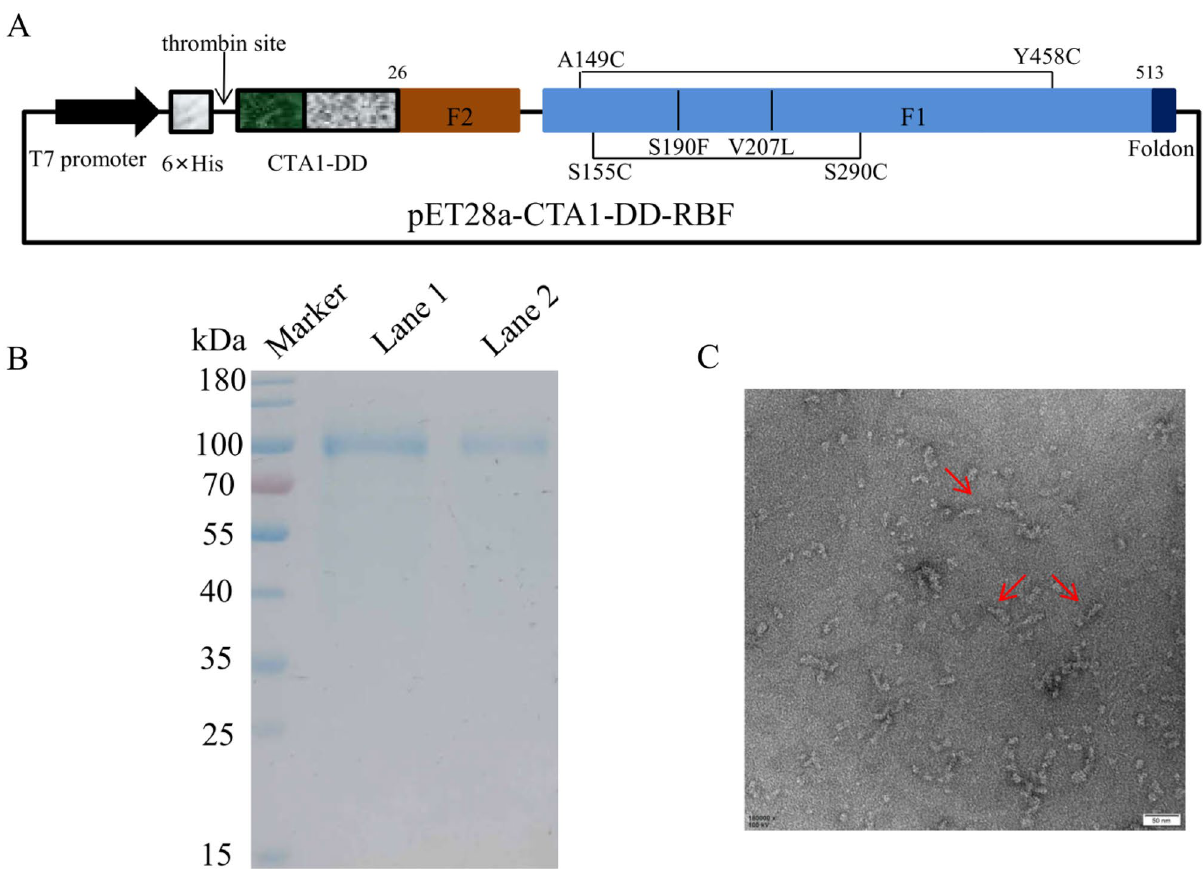
Figure 1. Design and analysis of the CTA1-DD-RBF protein. ( A ) Domain structure of the CTA1-DD-RBF protein. Mutations (Val to Leu at residue 207 and Ser to Phe mutation at residue 190; disulfide between residues 290 and 155) and disulfide bonds 149 to 458 were incorporated into the F protein and are indicated by vertical black lines. CTA1-DD-RBF contains the CTA1 subunit of cholera toxin (CT), two immunoglobulin (Ig) binding domains (DD) of staphylococcal protein A and hRSV F protein (residues 26–105 and 146–513) with a T4 fibritin trimerization motif (foldon) and a variable linker, GSGSG. ( B ) CTA1-DD-RBF proteins digested by thrombin on SDS-PAGE: Marker: protein markers; Lane 1: CTA1-DD-RBF purified using a HisTrap FF column after digested by thrombin; Lane 2, CTA1-DD-RBF purified by HisTrap FF columns before digested by thrombin. ( C ) Negative stain electron microscopy of CTA1-DD-RBF. The CTA1-DD-RBF was highly homogenous. Bar = 50